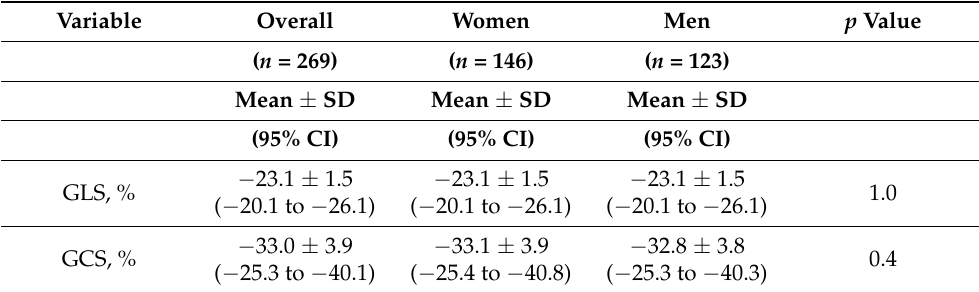
Table 4. Endocardial strain parameters in study population.